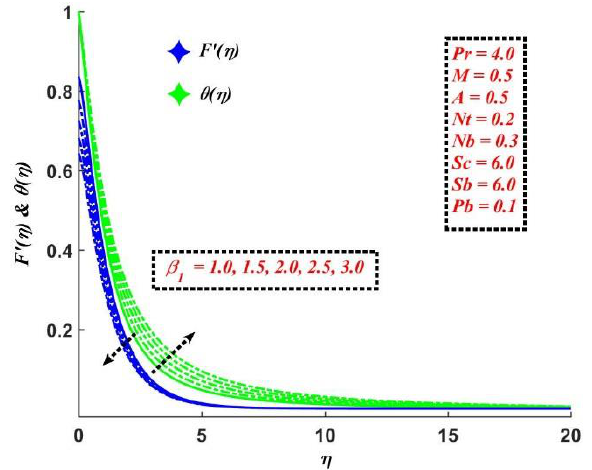
Figure 6. Influence of the slip parameter on 𝐹 ′ (𝜂) and 𝜃(𝜂) .